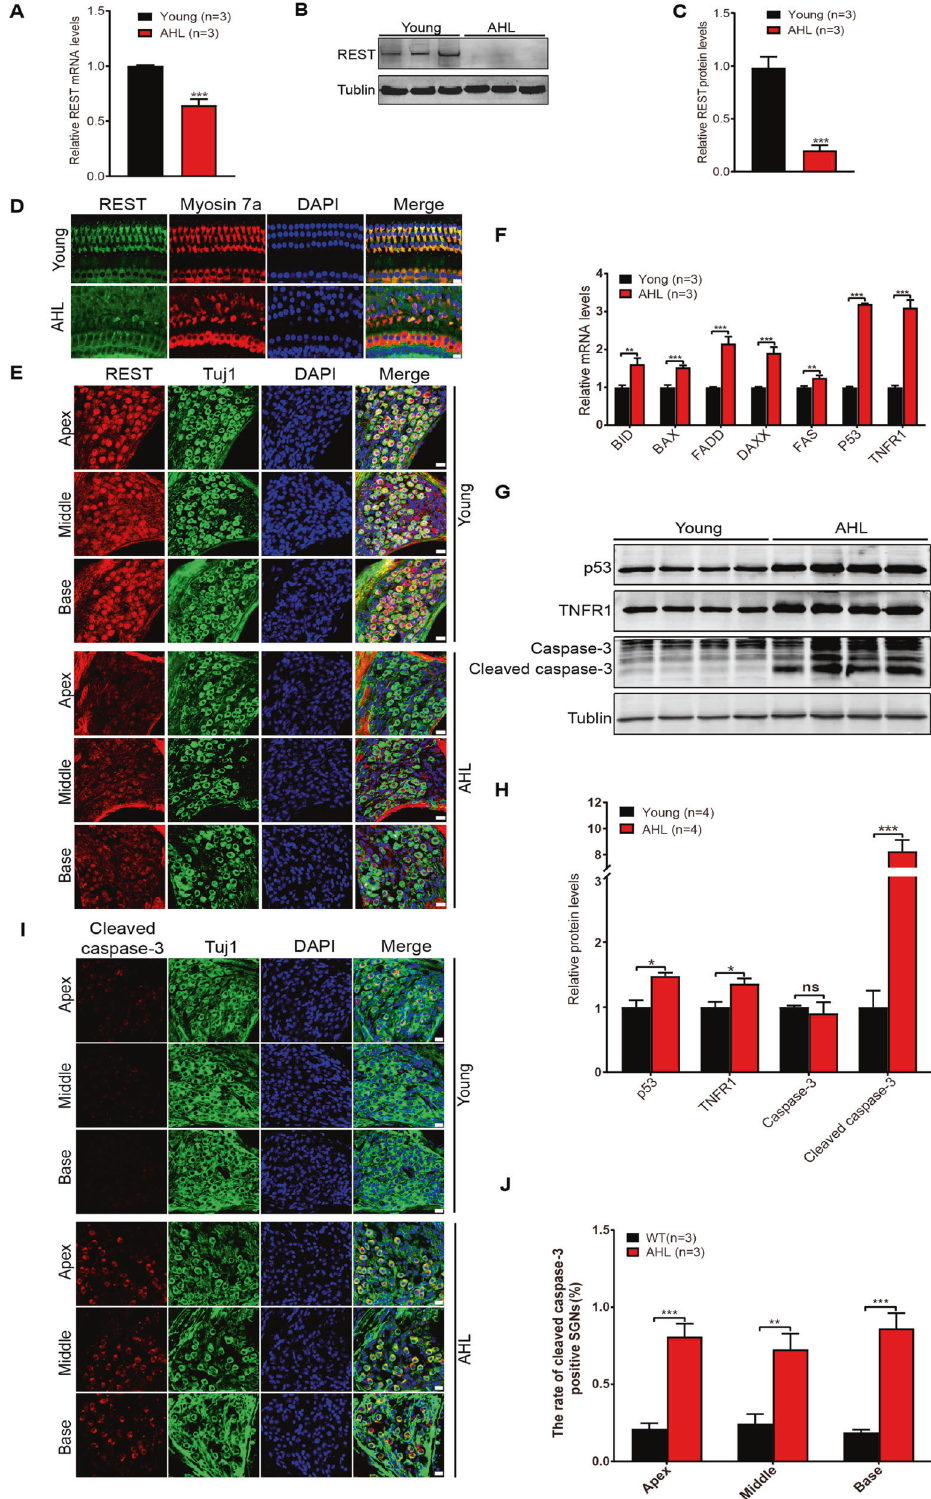
Fig. 2 Downregulation of REST in SGNs and HCs in AHL mice is associated with apoptosis. A – C REST expression was signi fi cantly decreased in the cochleae of AHL mice at the mRNA and protein levels, as determined by real-time PCR ( A ) and Western blotting ( B , C ). D , E Immuno fl uorescence showed REST expression in HCs ( D ) and SGNs ( E ) from young and AHL mice. Scale bar: 10 µm in ( D ), 20 µm in ( E ). F The mRNA expression levels of BID, BAX, FADD, FAS, P53, TNFR1 were signi fi cantly increased in cochleae from AHL mice. G , H The protein levels of p53, TNFR1, caspase-3 and cleaved caspase-3 were increased in AHL mice, as determined by Western blot ( n = 4). I , J Expression of cleaved caspase-3 in SGNs from young and AHL mice. Data are represented as mean ± SEM. ** P < 0.01, *** P < 0.001.